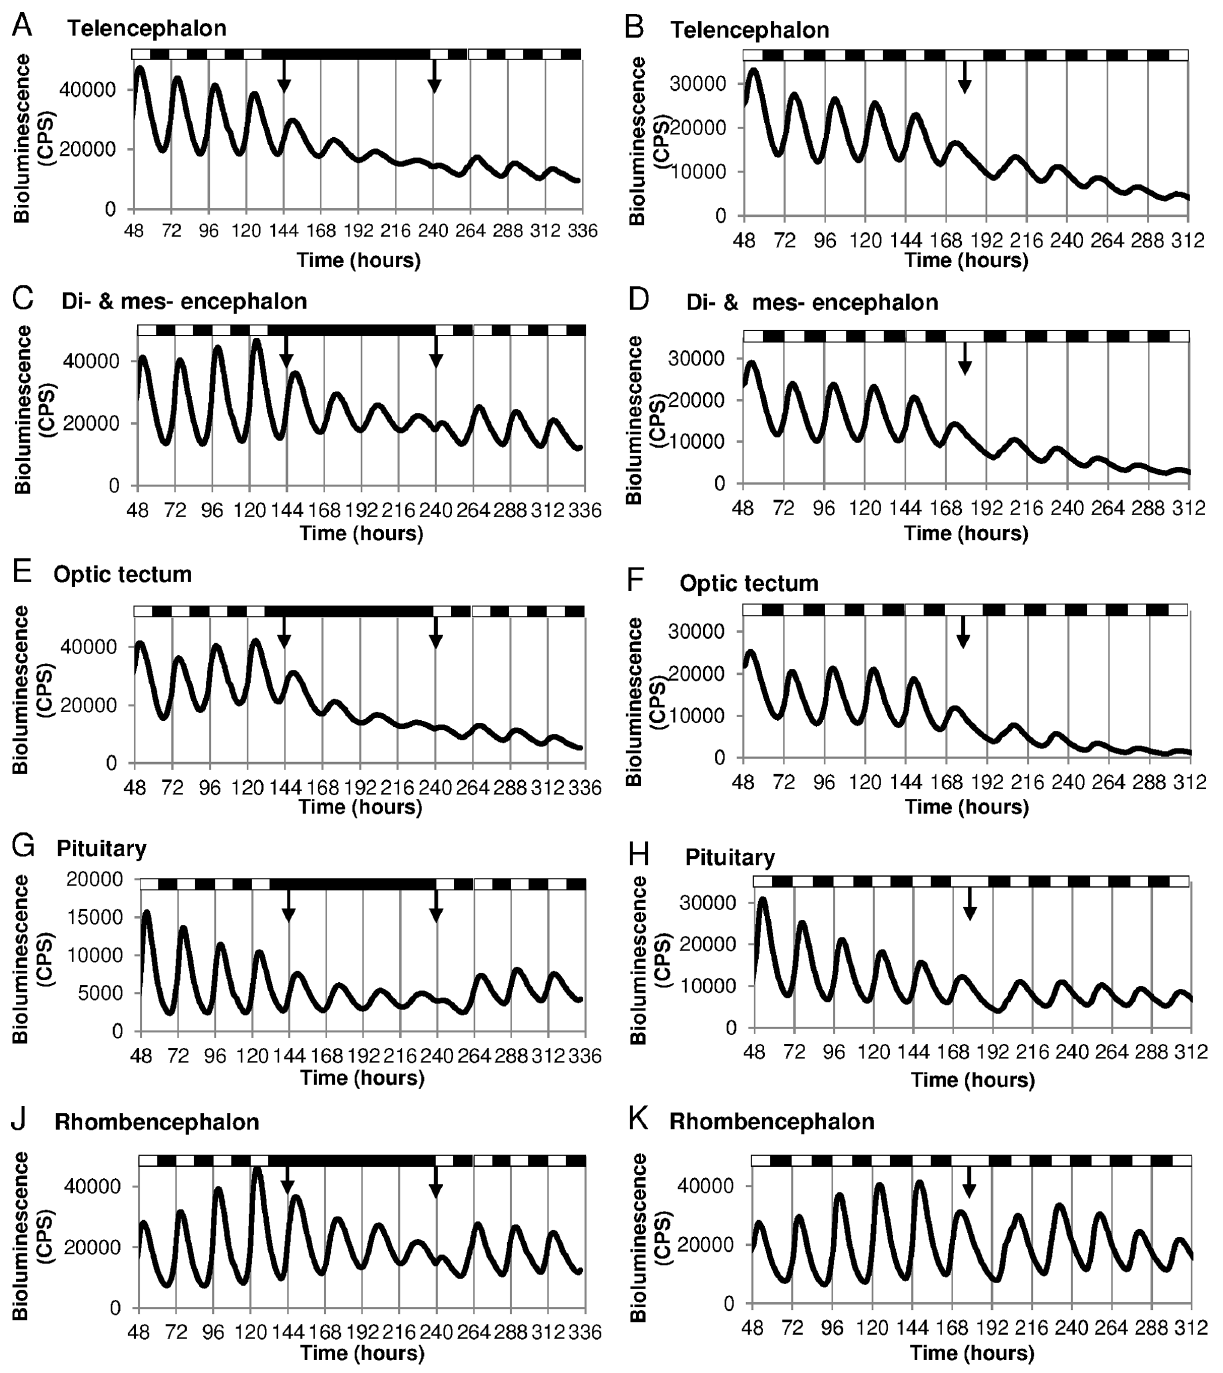
Figure 2. Per3 rhythms in all isolated regional brain cultures from per3-luc zebrafish show entrainment to LD cycles and free- running in DD. Brains were dissected from adult per3-luc zebrafish and monitored for bioluminescence in either (A, C, E, G, J) 6 days of 12:12LD, 4 days of DD and 4 days back into LD, or (B, D, F, H, K) 7 days of 12:12LD followed by five cycles of 12:12DL. The mean bioluminescence in counts per second (CPS) is plotted (n=3–4). All brain regions entrain to a 24-hour period in the LD cycle with a peak around ZT4–6 and free-run with a longer period in DD (p , 0.0001, two-tailed paired t-test, n=3–4 per tissue). All regions rapidly entrain to a new LD cycle or DL cycle with a peak at ZT3-5. Black and white boxes indicate the lighting regime and arrows indicate when this changes. doi:10.1371/journal.pone.0086176.g002 per3 expression, including the teleost equivalent of the SCN, the body staining within these brain nuclei can be clearly seen in Figure 3. It is hard to make meaningful comparisons, based on paraventricular organ (PVO) (PVN in mammals), the PGZ of the anatomy, between clock function in zebrafish and the well- optic tectum, and multiple hypothalamic nuclei. A summary of characterized mammalian brain. However, several of these these results can be found in Table S1. The strong neuronal cell